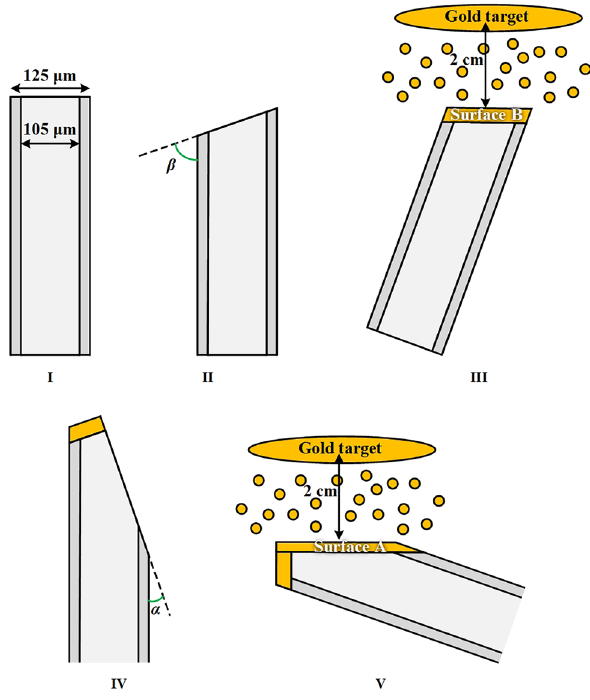
Figure 5: Flowchart for fabricating the wedge-shaped fiber tip sensor probe based on SPR.